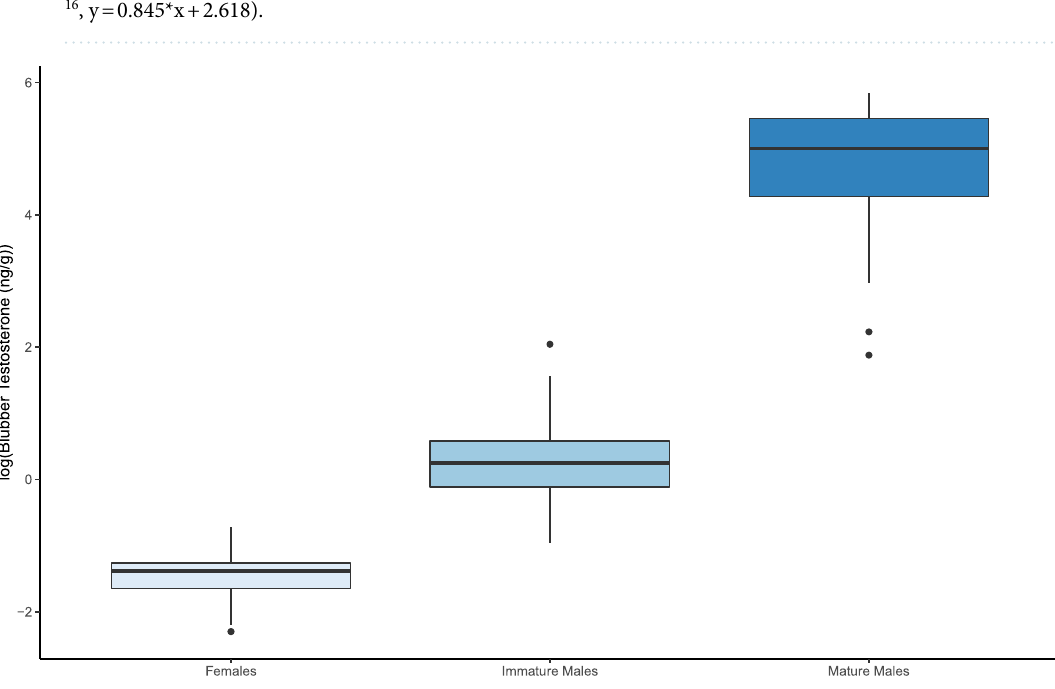
Figure 2. Mean blubber testosterone concentrations (ng/g lipid mass) for female, immature male, and mature male T. truncatus from Sarasota Bay, FL. Horizontal box lines represent the upper quartile, median, and lower quartile values. Whisker lines represent values within the 1.5 × interquartile range and the dots represent